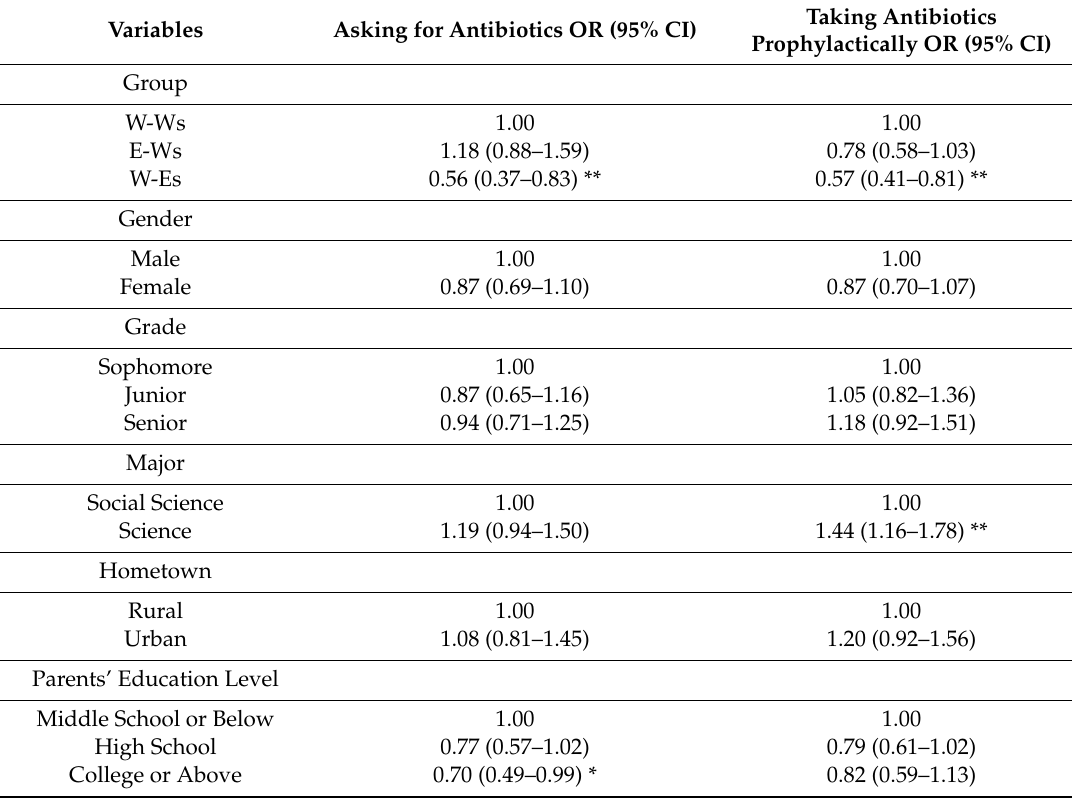
Table 5. Changes in antibiotic use behaviors among students who were from the western region or attended western